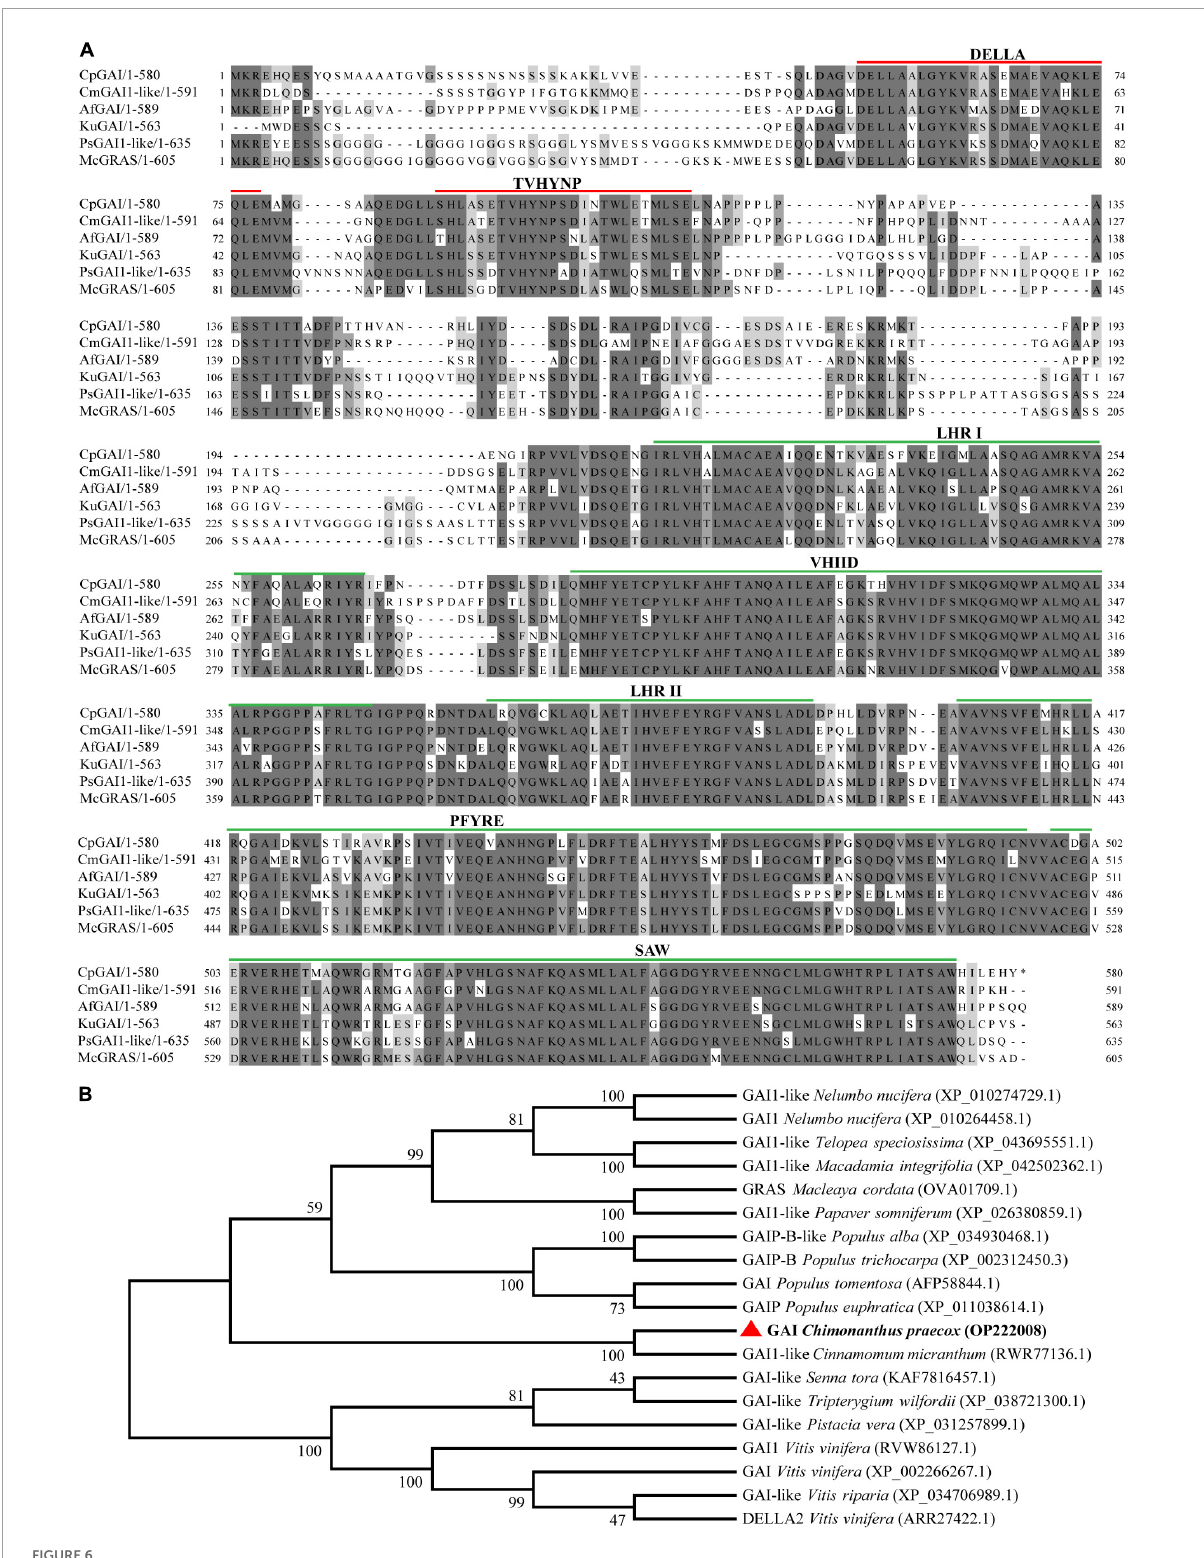
FIGURE6 CpGAI amino acid sequence alignment and phylogenetic analysis. (A) Multiple sequence alignment of CpGAI protein with the proteins of Cinnamomum micranthum , Aristolochia fimbriata , Kingdonia uniflora , Papaver somniferum , and Macleaya cordata. The line above shows the location of the conservative area. (B) Phylogenetic analysis of the CpGAI protein and GAI of other species; red triangle represents